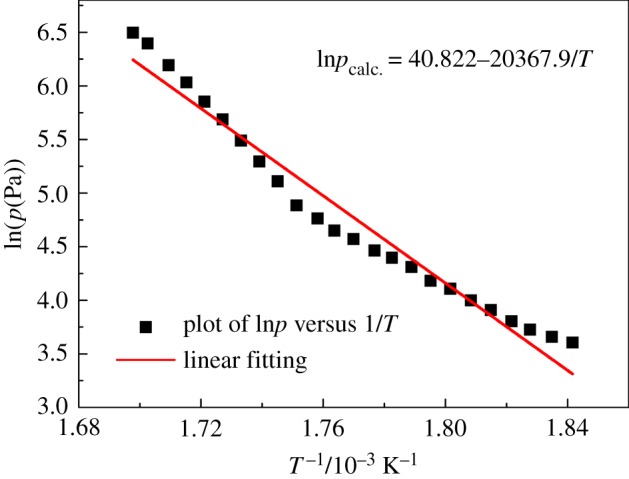
Plot of lnp versus 1/T for hafnium n-propoxide.